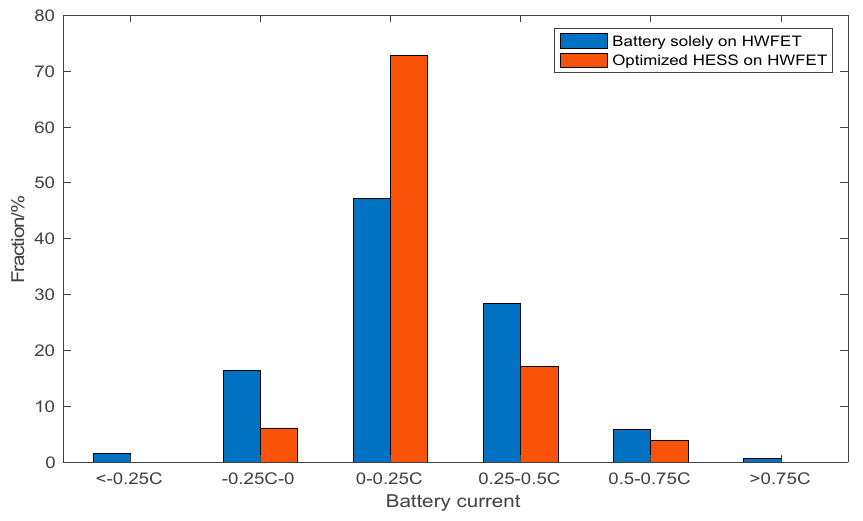
Figure 14. Battery current distribution.